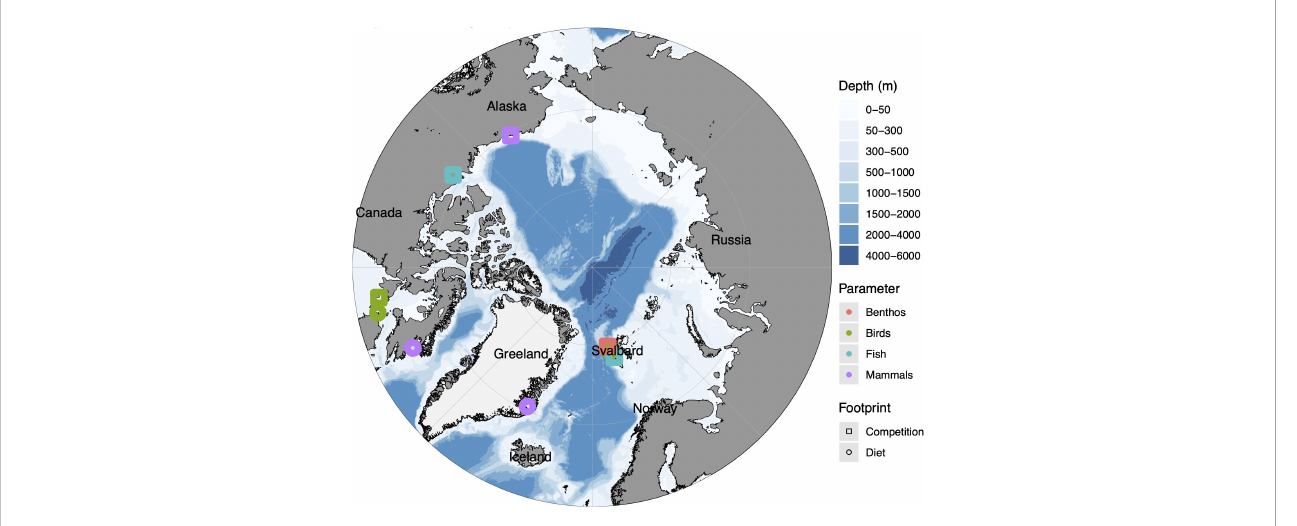
FIGURE 4 Map of the geographical distribution of all recorded secondary footprints on a pan-Arctic scale. The colours present the different animal parameters, while the shape represents the type of footprint. A summary of all relevant papers sorted by footprint types and parameters in Supplementary Tables 7,